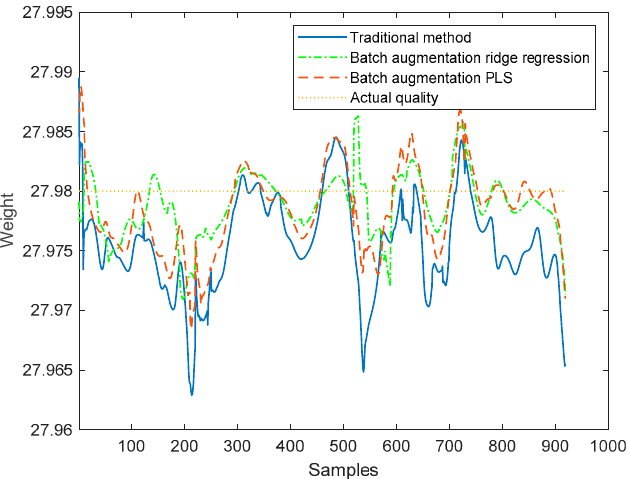
Figure 11. Quality prediction of batch 65.